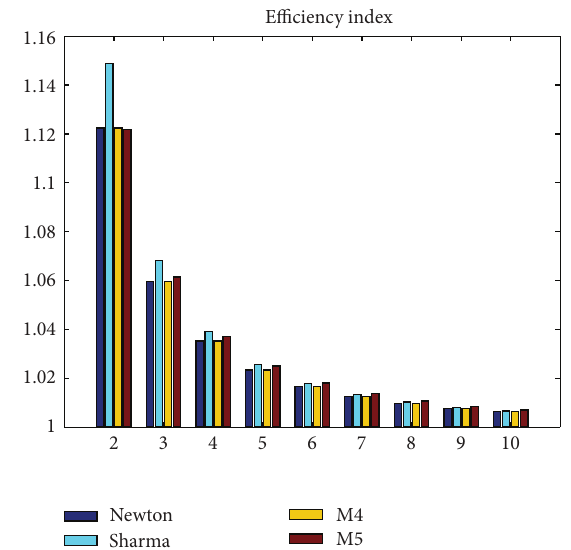
Figure 2: Comparative among the efficiency indices of the methods.